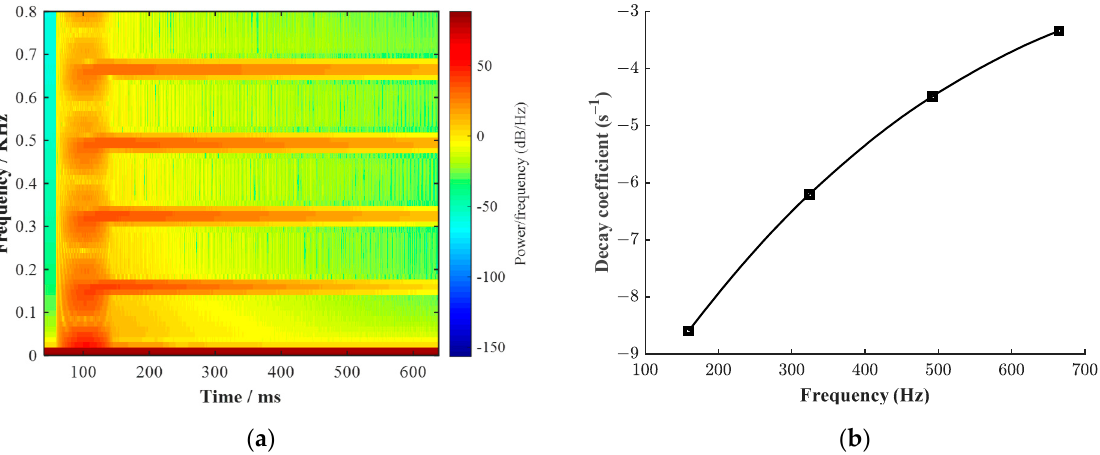
Figure 16. The time ‐ frequency spectrogram and the decay coefficient under different acoustic fre ‐ Figure 16. The time-frequency spectrogram and the decay coefficient under different acoustic fre- quency computed from the C0 model with cavity. ( a ) The time ‐ frequency spectrogram of the pres ‐ quency computed from the C0 model with cavity. ( a ) The time-frequency spectrogram of the pressure sure oscillations, ( b ) The decay coefficient under different acoustic frequency. oscillations. ( b ) The decay coefficient under different acoustic